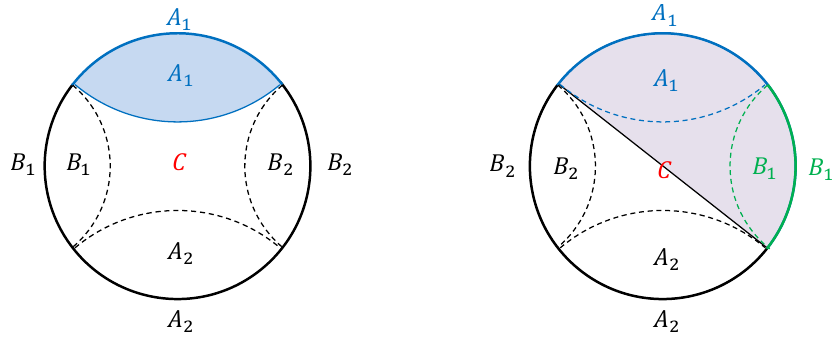
Figure 10 . The entanglement wedge of A 1 (left) and that of A 1 ∪ B 1 (right). The entanglement wedge of A 1 does not includes C , and similarly, the regions of each of R + , R − , B + or B − does not include the island I (see figure 5). The entanglement wedge of A 1 ∪ B 1 includes a half of the region C . This is similar to the region of R + ∪ B + and that of R + ∪ B − — the effective region includes a half of the island in both